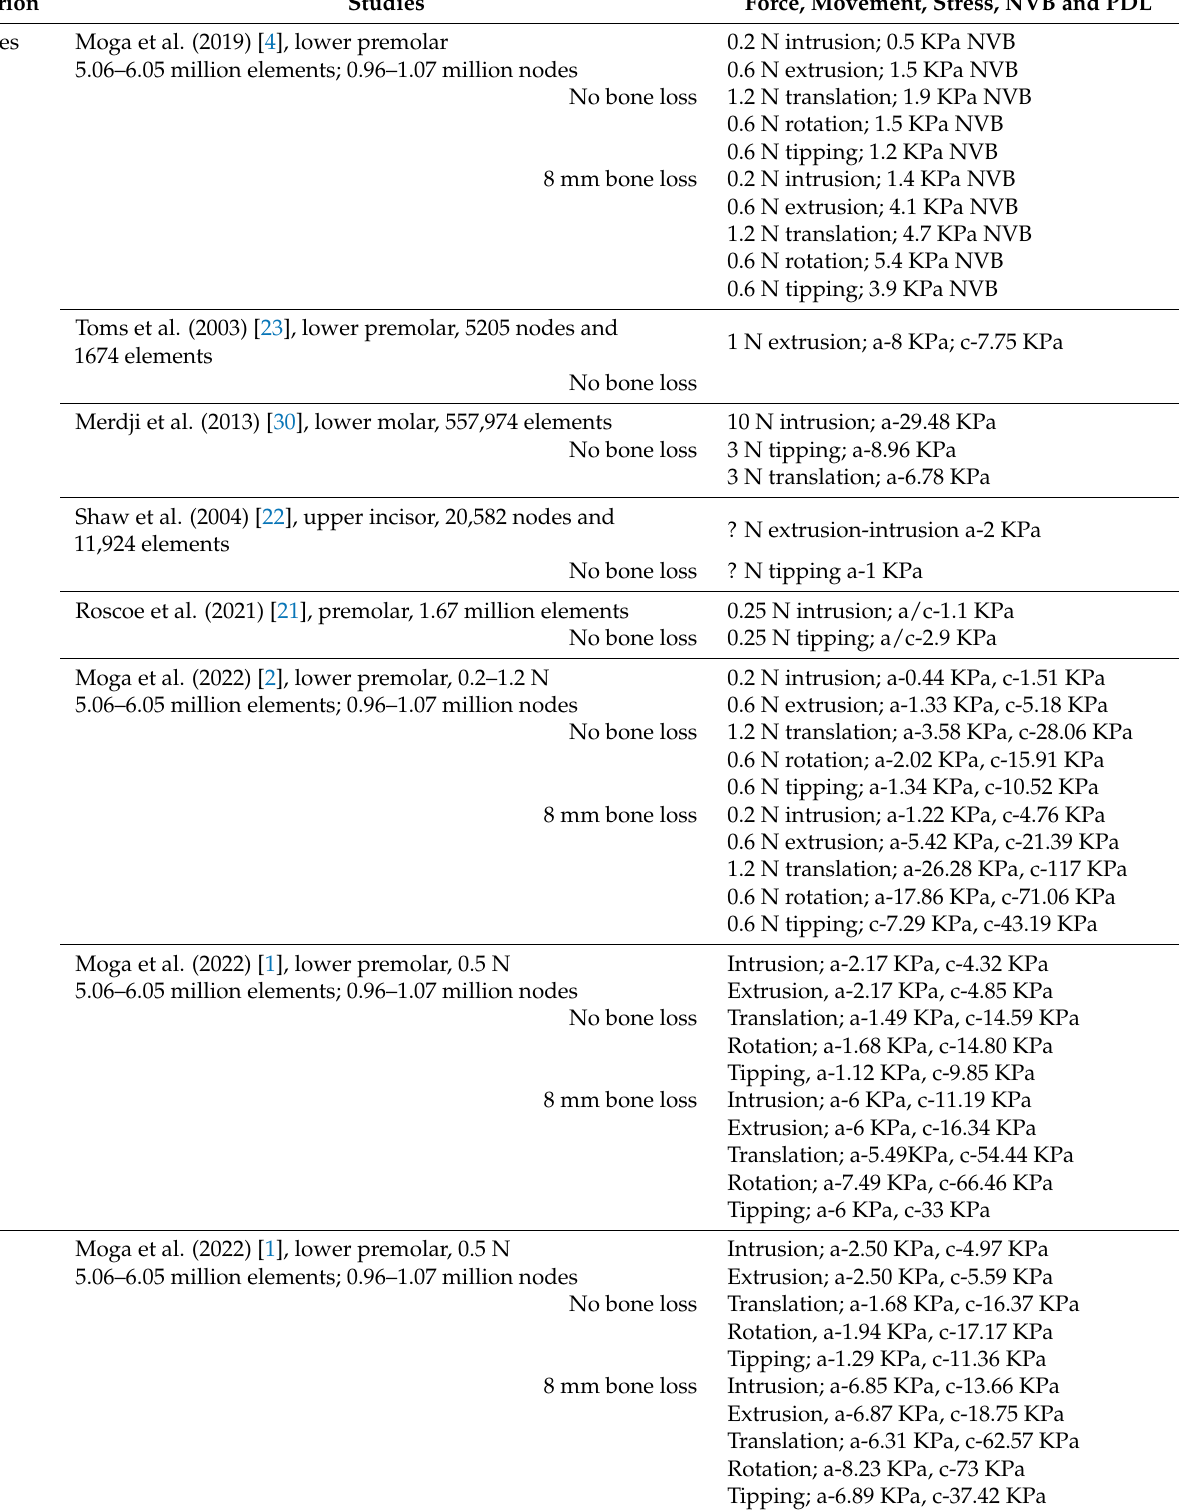
Table 4. Quantitative reports for apical NVB and PDL (a—apically, c—cervically). FEA